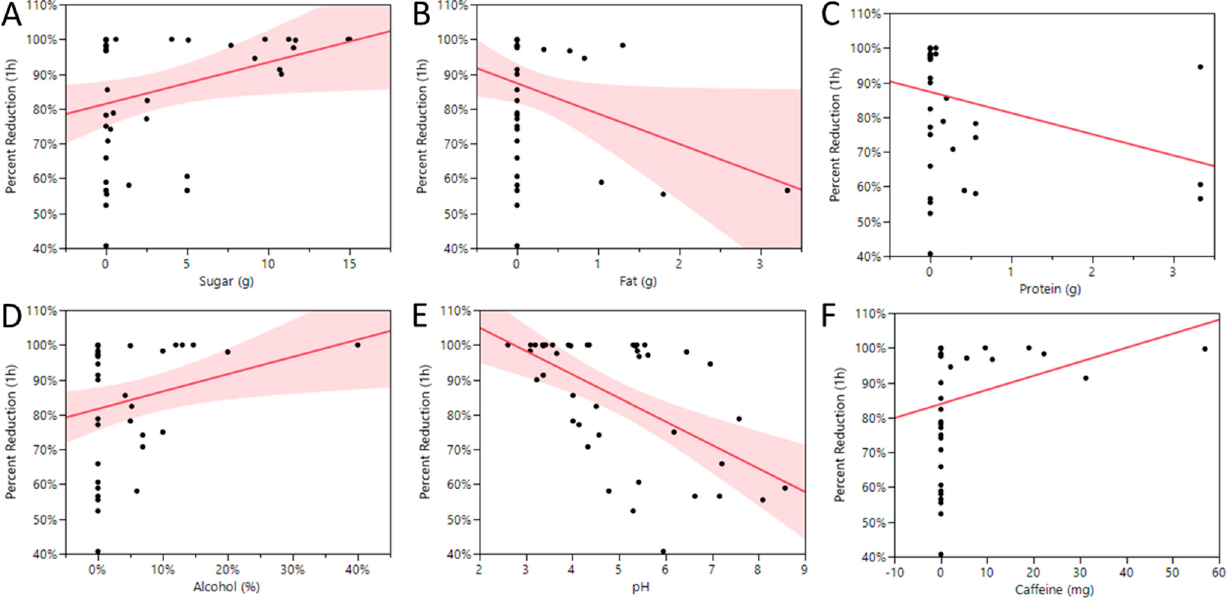
Figure 6. Correlations between beverage characteristics and percent reduction in virus titer at 1 h. Higher concentrations of sugar ( A ) and alcohol ( D ) correlate with greater reduction in virus titer by 1 h post-inoculation ( p = 0.0378, and 0.0189, respectively). Increased percentage of fat ( B ) and higher pH ( E ) correlate with less reduction in virus titer by 1 h post-inoculation ( p = 0.0478 and <0.0001, respectively. Shaded areas = confidence intervals (0.05). No correlation was found between protein ( C ) or caffeine ( F ) content and reduction in virus titer by 1 h post-inoculation ( p > 0.05). Bivariate analysis, Table 1. Beverage characteristics (per 100 mL).